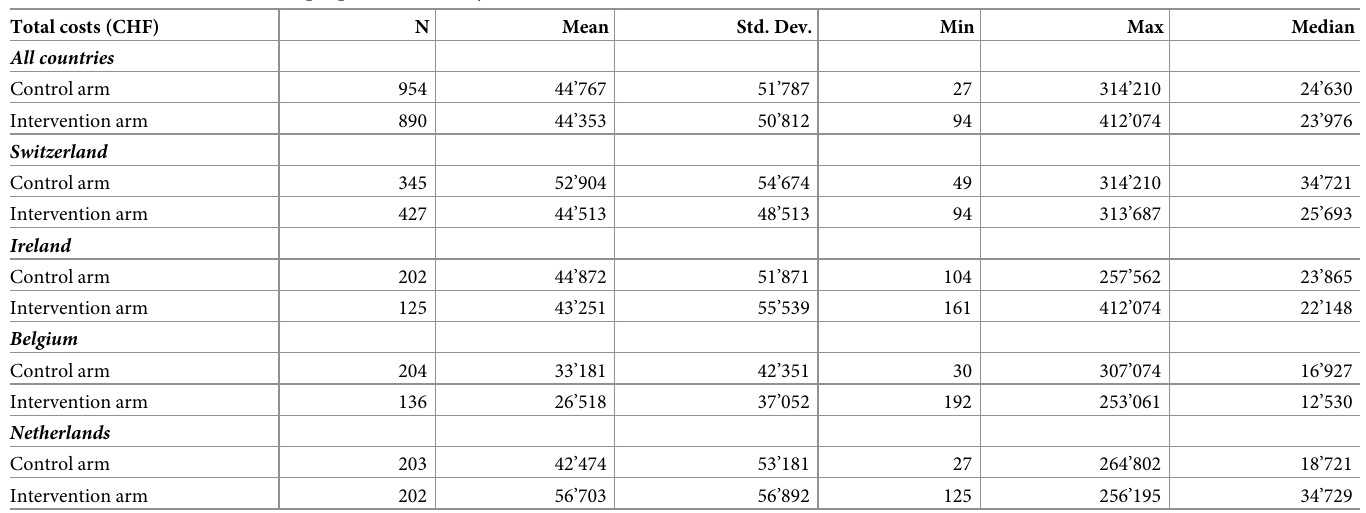
Table 2. Total medical costs (CHF) per patient over one year.